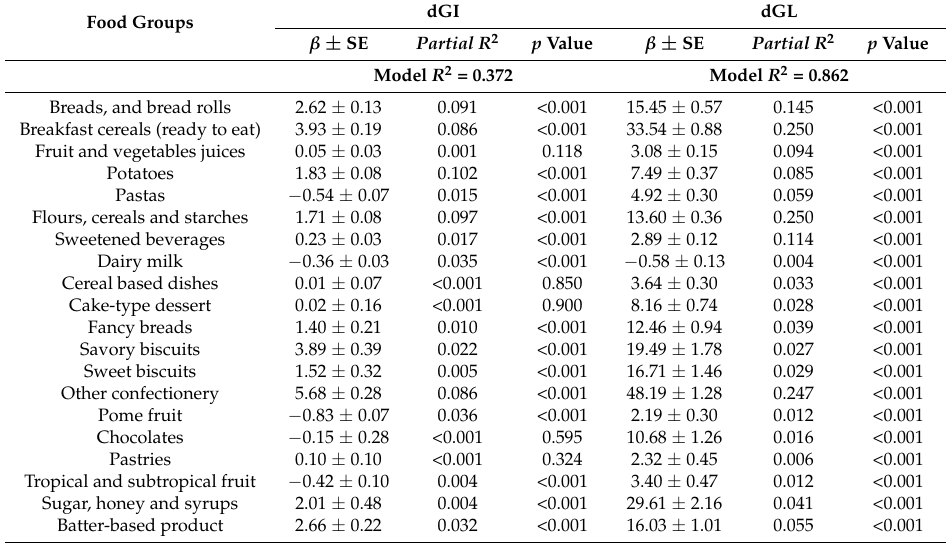
Table 6. The contribution of the top 20 GL food groups to inter-individual variations in dietary glycaemic index (dGI) and glycaemic load (dGL) in 2007NS ( n = 4373). Food Groups